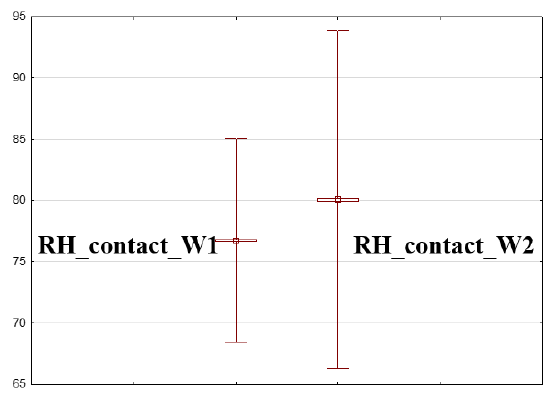
Figure 14. Box-whisker plot for relative humidity (RH) values for the analyzed variants: average, standard error, and standard deviation.